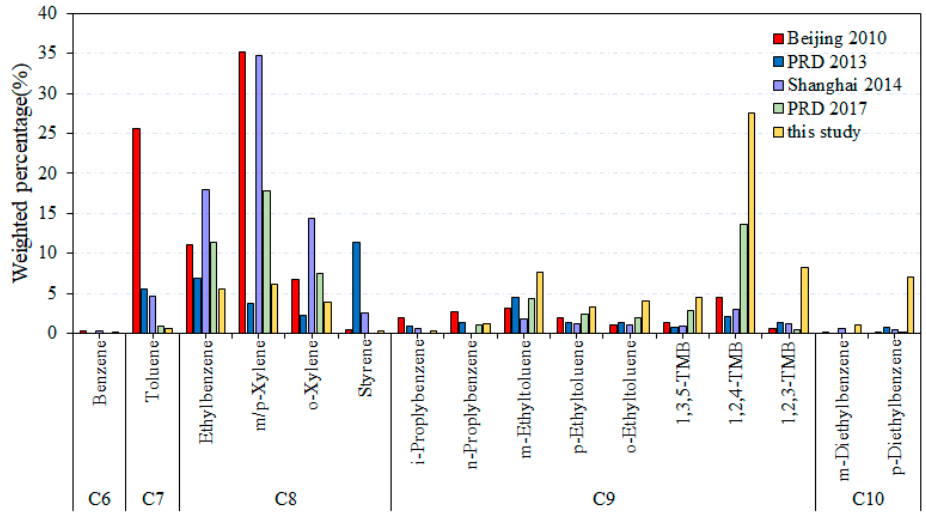
Figure 7. Comparison of major aromatics from auto coating in different regions.